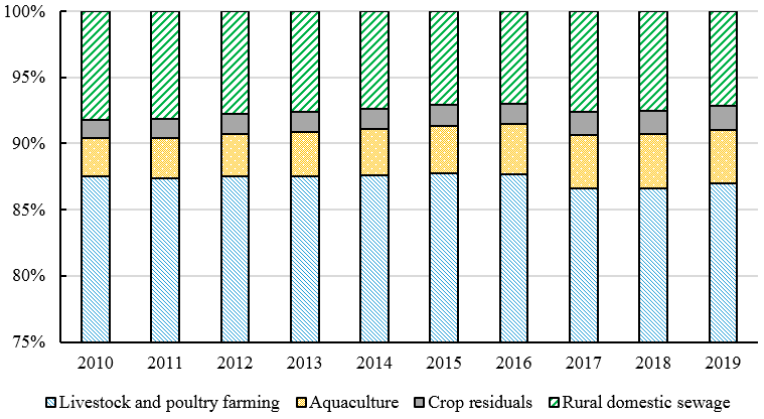
Figure 4. The proportion of COD emissions from different sources from 2010 to 2019.